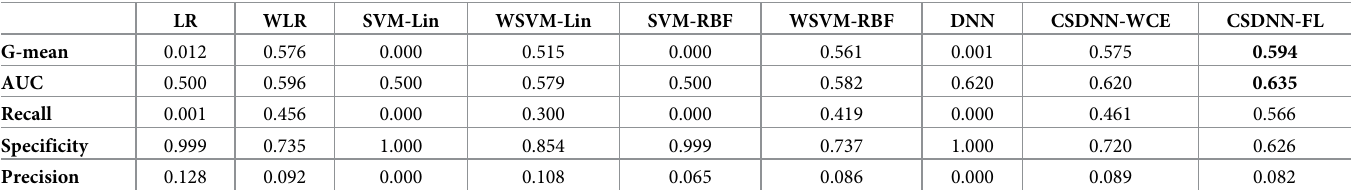
Table 17. Comparative results of CSDNN-WCE and CSDNN-FL against Logistic Regression (LR), Weighted LR, Support Vector Machine (SVM-Lin), Weighted SVM-Lin (WSVM-Lin), SVM with Radial Basis Function (SVM-RBF), Weighted SVM-RBF (WSVM-RBF), and DNN using Oklahoma data. The highest average G- mean and AUC values are denoted in bold.